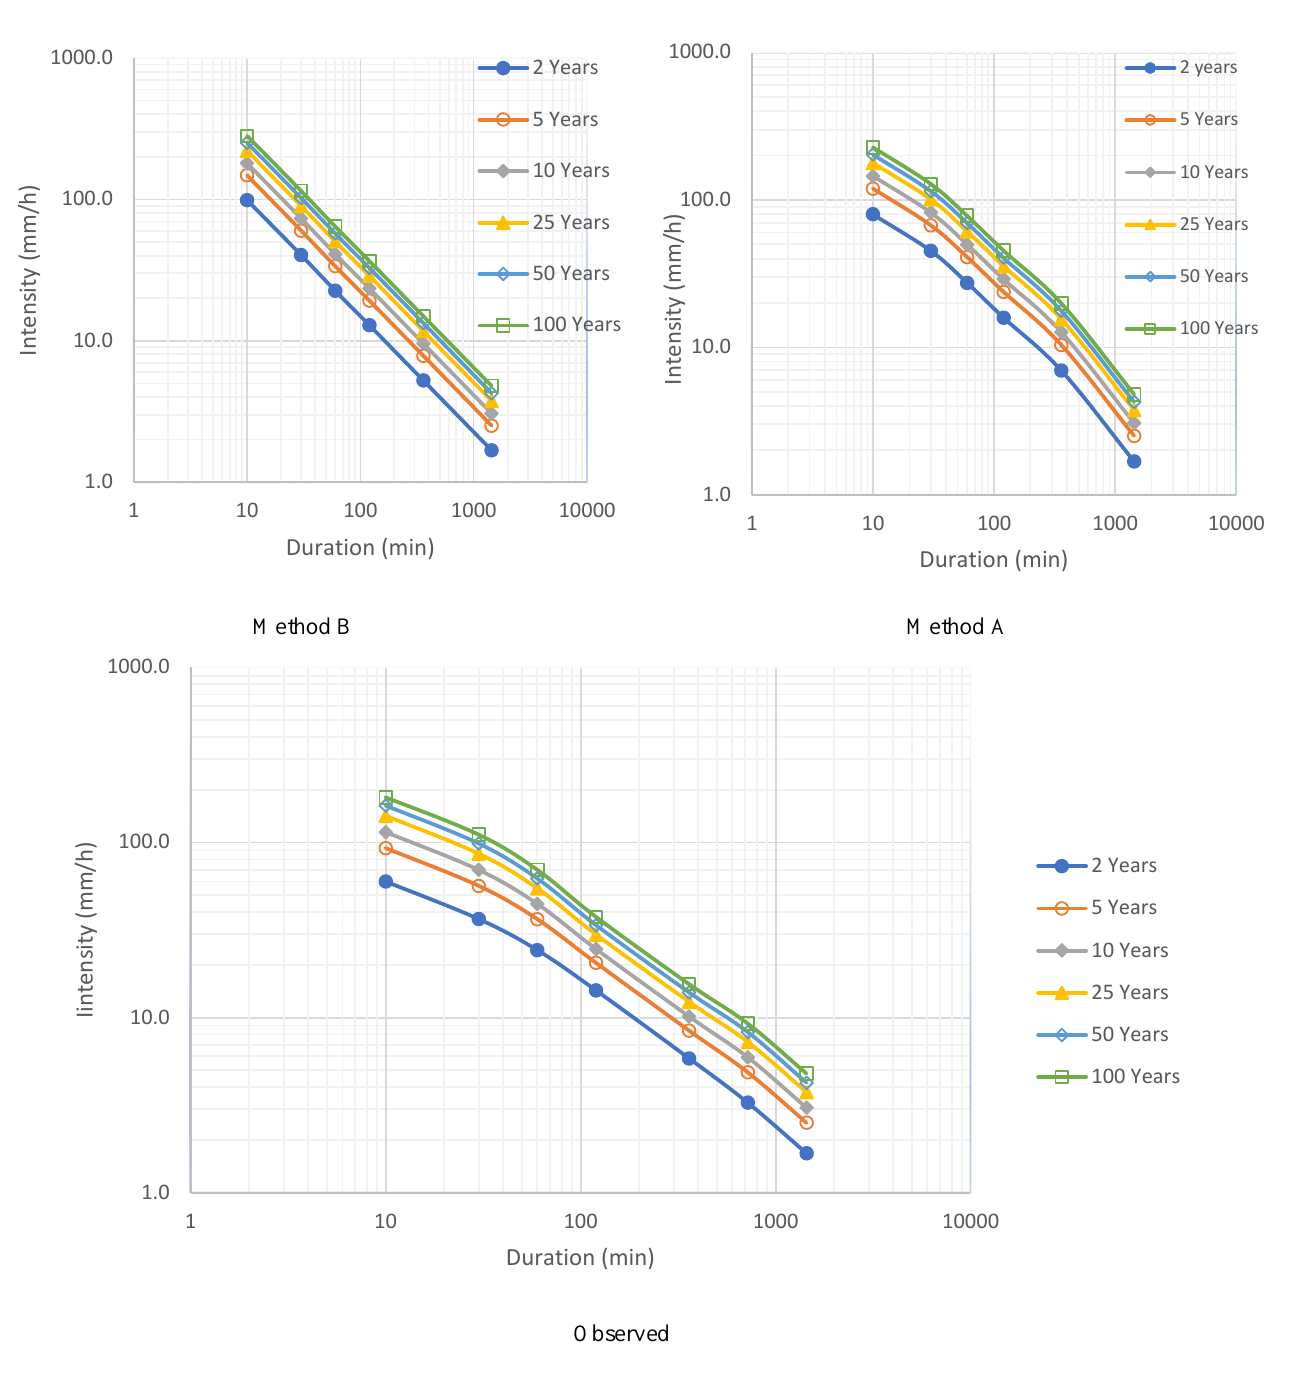
Figure 5. IDF curves by using Gumbel distribution of Yalamlam area (method A, B and